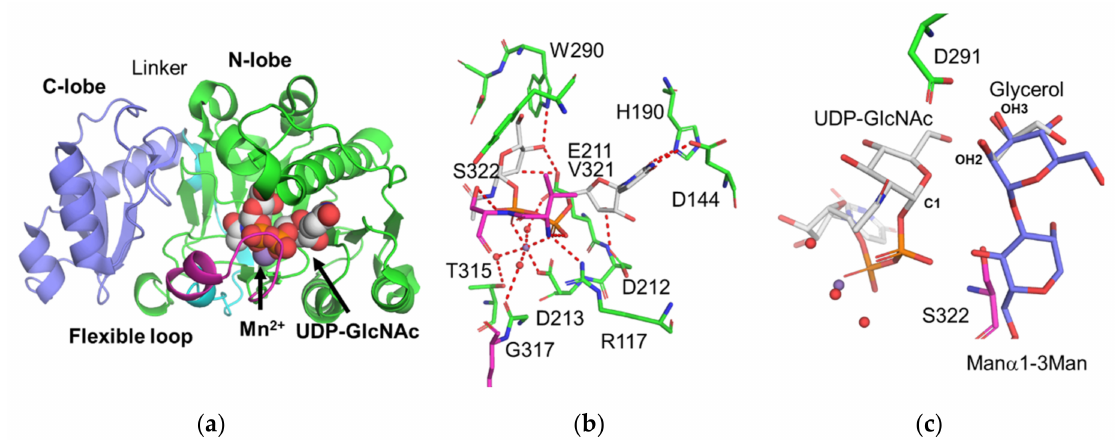
Figure 2. Crystal structure of rabbit GnT-I. ( a ) Crystal structure of rabbit GnT-I in complex with UDP-GlcNAc and a Mn 2 + ion (PDB code: 1FOA). Protein and ligands are shown as ribbon and sphere models, respectively. The N-lobe (106–317), flexible loop (318–330), linker (331–353), and C-lobe (354–447) are green, magenta, cyan, and blue, respectively. The colors of sphere models are as follows: carbon (grey), oxygen (red), phosphorus (orange) and manganese (purple). ( b ) Close up view of the UDP-GlcNAc binding site. Amino acid residues that interact with UDP-GlcNAc or the Mn 2 + ion are shown as rod models. Mn 2 + , and three water molecules which coordinate with Mn 2 + ion are shown in sphere models. The hydrogen and coordination bonds are shown in red dotted lines. ( c ) Putative acceptor-binding mode. The Man α 1-3Man unit (colored in blue) is superimposed onto the glycerol molecule observed in GnT-I UDP-CH 2 -GlcNAc complex (PDB code: 2AM3). The side chain of D291